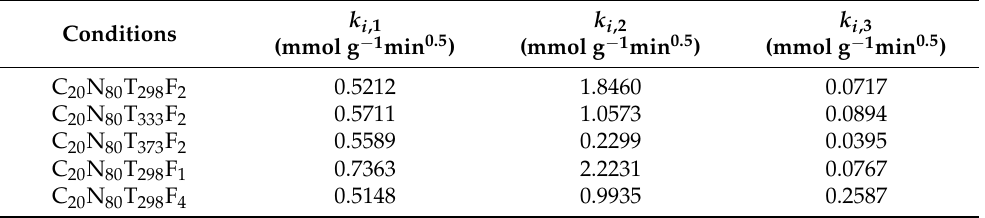
Table 5. The diffusion kinetics constant of CO 2 adsorption from CO 2 /N 2 gas mixture on zeolite